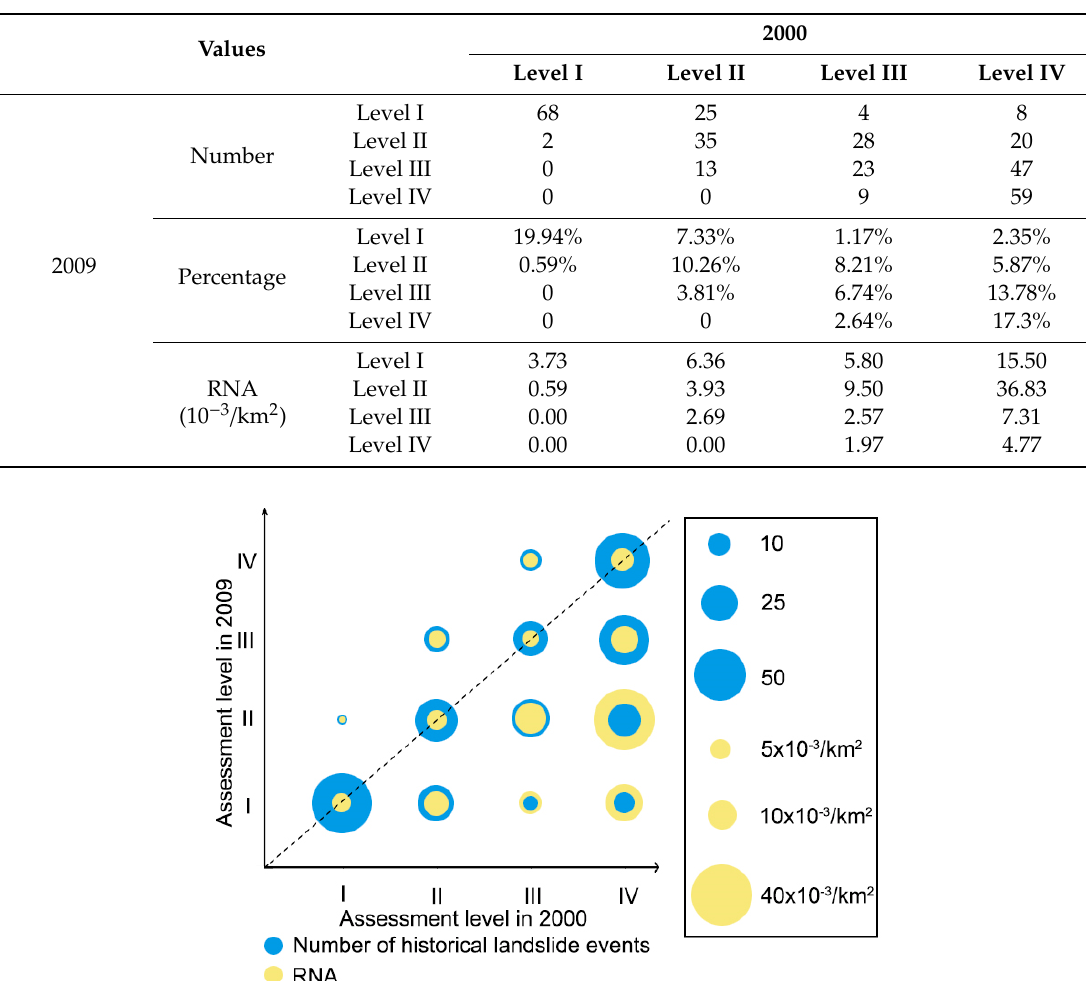
Table 8. Numbers and percentages of historical landslide events at various assessment levels and RNA values of various assessment levels.